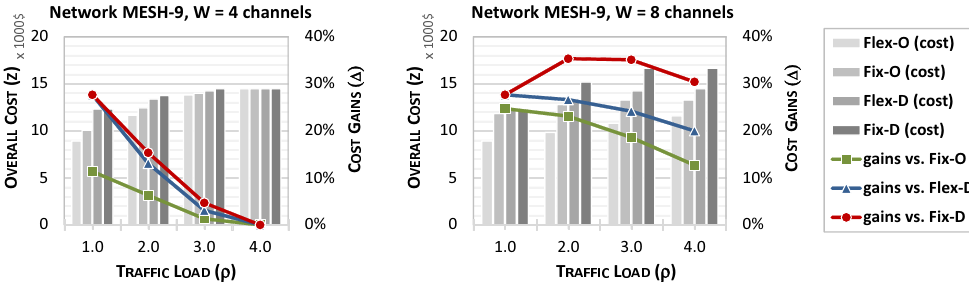
Figure 6. Overall network cost in different scenarios (bars) and cost gains achieved with flex-O vs. reference scenarios (lines) as a function of traffic load ( ρ ) for different WDM capacities ( W ) in MESH-9.